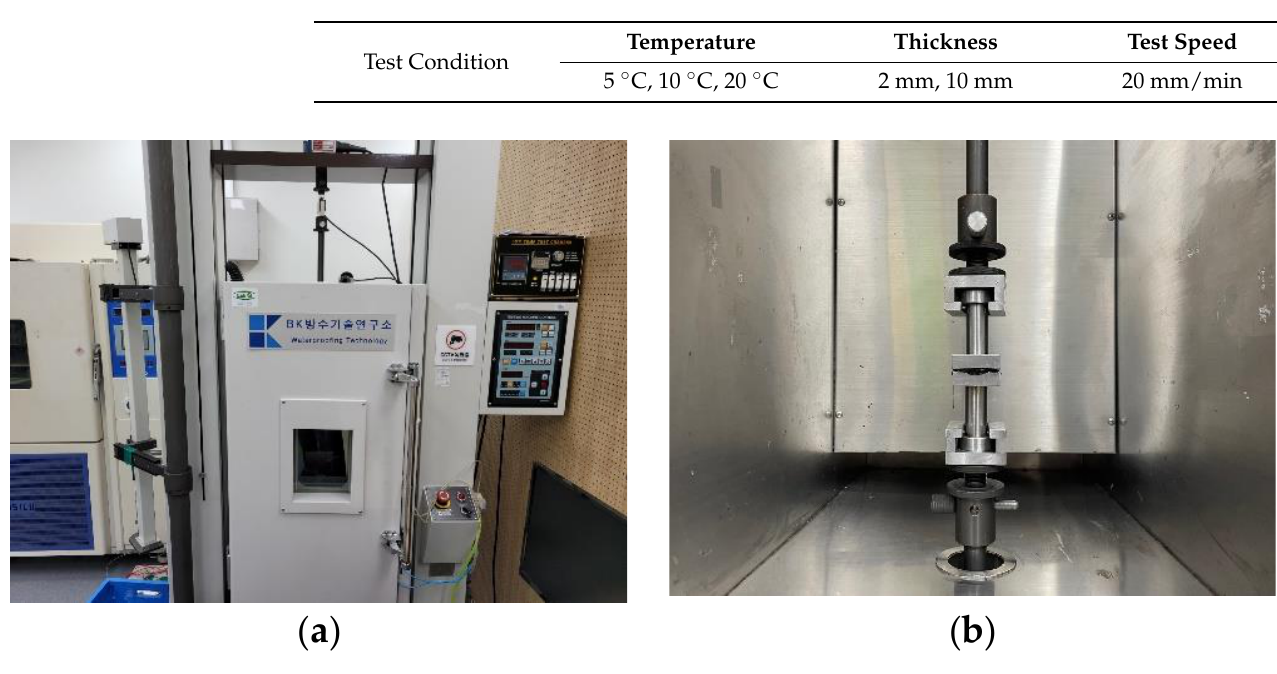
Figure 5. UTM Testing apparatus; ( a ) UTM, ( b ) apparatus set-up within the UTM for testing.